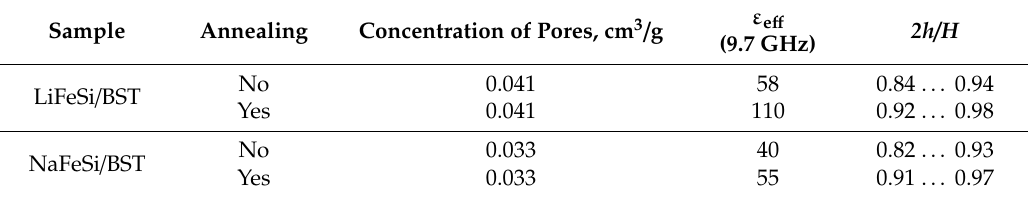
Table 2. Parameters of the NaFeSi / BST and LiFeSi / BST